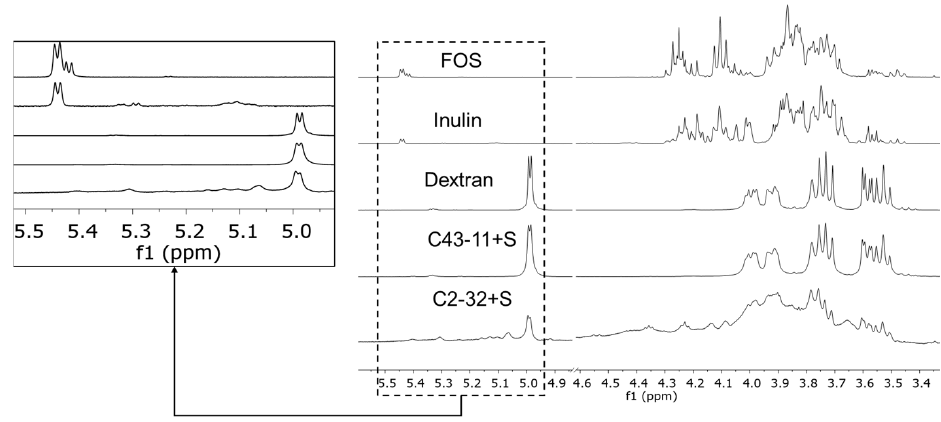
Figure 1. Typical 1D 1 H NOESY NMR spectra (D 2 O, 400 MHz, 303 K) of fructooligosaccharide (FOS), inulin, dextran (MW 270 kDa) and purified samples from C43-11 + S and C2-32 + S.